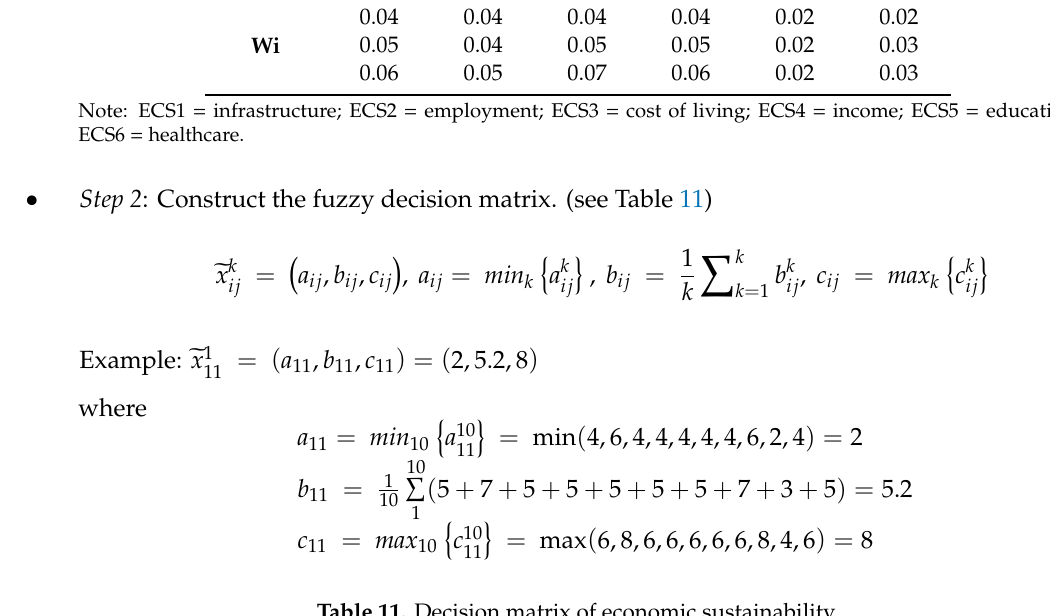
Table 11. Decision matrix of economic